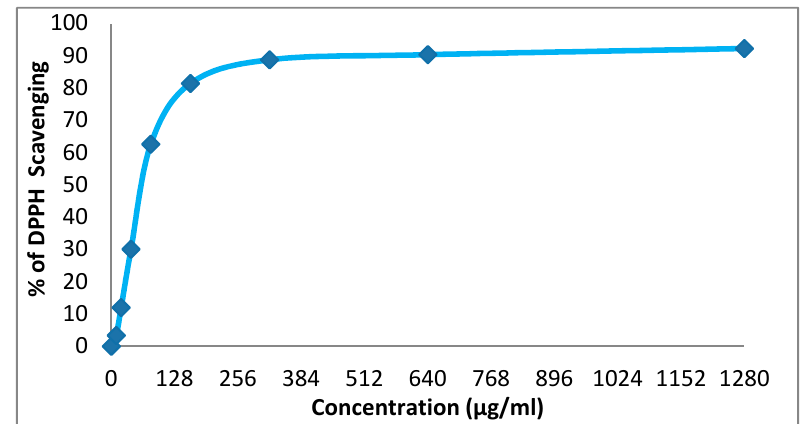
ff ect of disperse dye